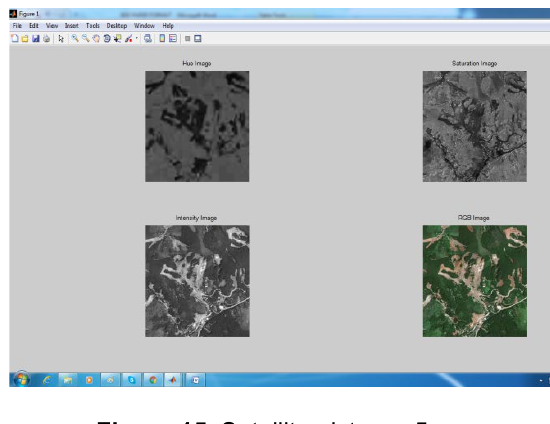
Figure 15. Satellite picture - 5 The equivalent noise estimates are measured for every filter as given in Figure 16 , noises exist in the pictures.